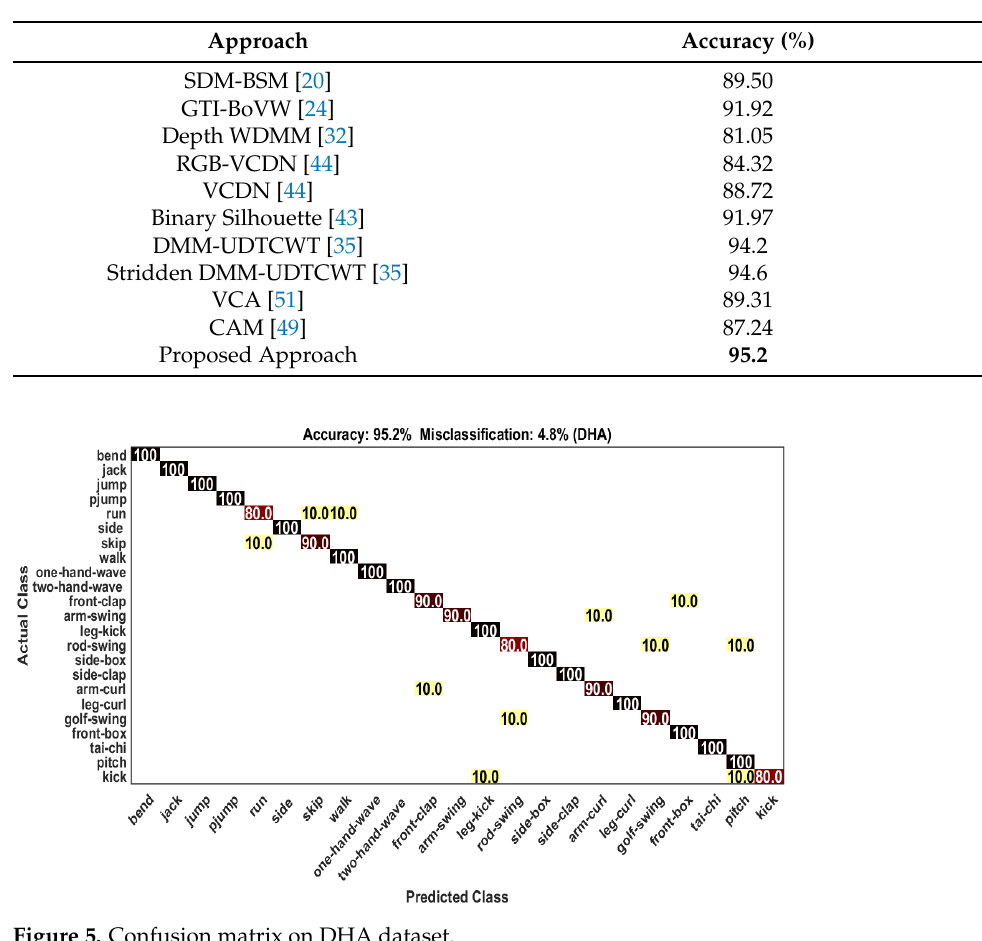
Table 3. Comparison of action recognition accuracy (%) with state-of-the-art frameworks on the DHA dataset.